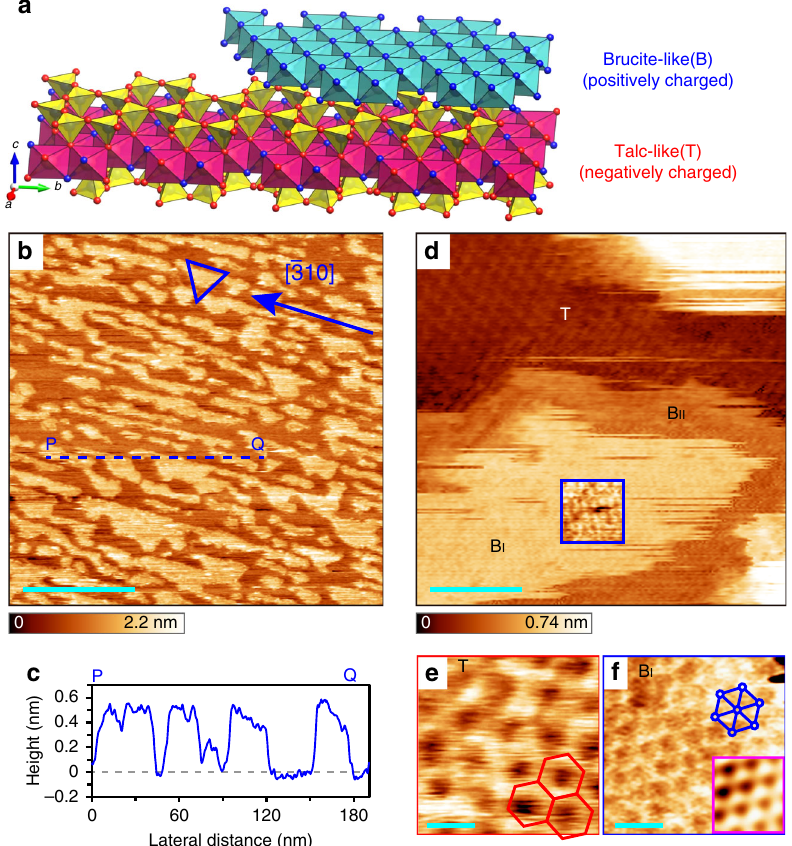
Fig. 1 FM-AFM images of clinochlore. a Crystal structure of clinochlore crystal, which is composed of negatively charged talc-like (T) and positively charged brucite-like (B) layers. The fi gure was drawn using VESTA 42 . b Topographic image of the clinochlore (001) surface. The triangle shows the characteristic shapes due to the partial dissolution of the B layer 29 . c Cross-sectional pro fi le along the P – Q line indicated in b . d Atomic-resolution image of the clinochlore (001) surface showing that the B island has two regions (B I and B II ) with different heights. In the blue square, the contrast was enhanced and smoothed by a Gaussian fi lter. e , f Magni fi ed atomic-resolution images taken on the T region ( e ), and B I region ( f ), with the inset of an FFT- fi ltered image. All of the images were acquired with Δ f ~ + 300 Hz. Scale bars: 100 nm ( b ), 3 nm ( d ), and 0.5 nm ( e , f